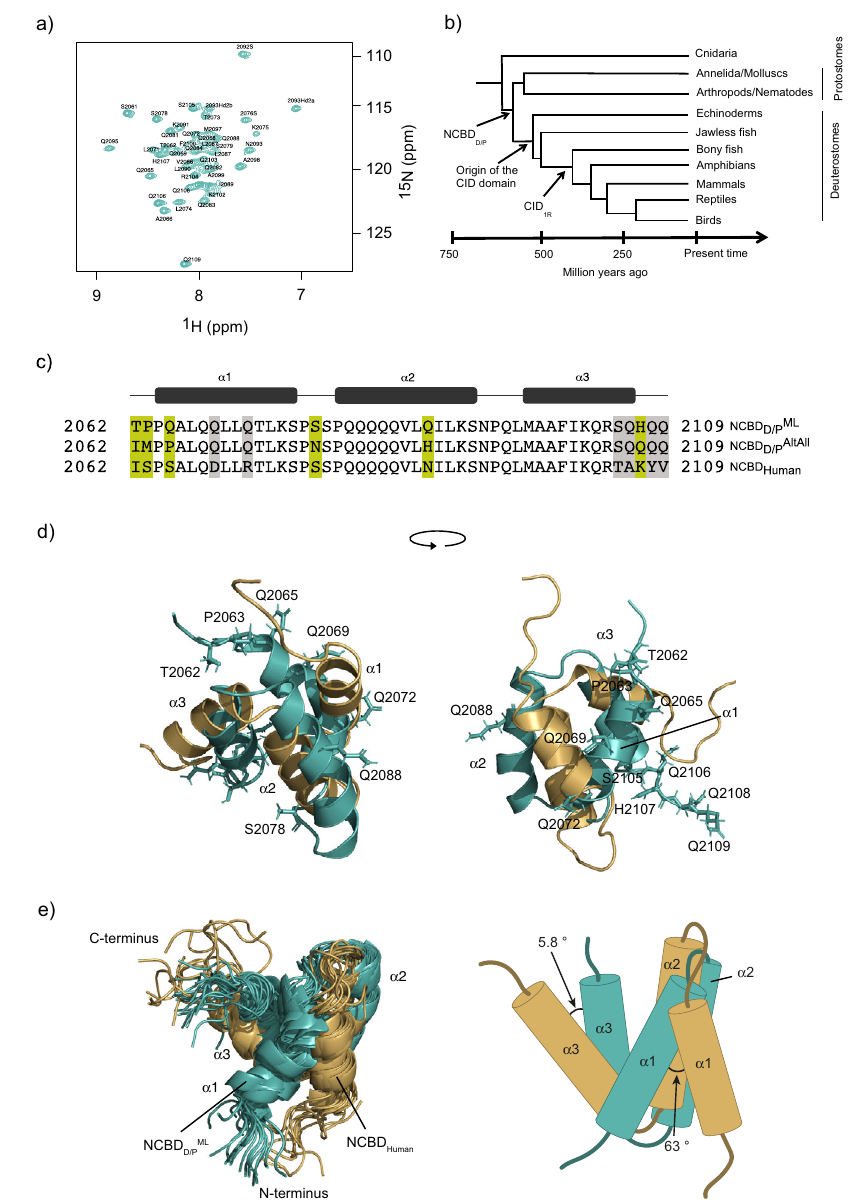
Fig. 1 Structures of ancestral and human NCBD domains. a 1 H- 15 N HSQC spectrum of NCBD D/P ML at pH 2.4 with assigned residues. All assignments and the structural coordinates have been deposited in the PDB data bank with accession number BMRB ID 34635 and PDB code: 7OSR. b A schematic tree depicting the relationship between the deuterostome/protostome (D/P) ancestor and modern species. The time points on the x-axis are approximate, in particular the divergence of protostomes and deuterostomes. c Sequence alignment for NCBD Human , NCBD D/P ML , and NCBD D/P AltAll . The residues differing between NCBD D/P ML and NCBD D/P AltAll are marked in celery green while additional differences to NCBD Human are marked in gray. d , e Comparison of the NMR structure of ancestral NCBD D/P ML solved at pH 2.4 (teal, PDB code: 7OSR), and the previously determined human NCBD (gold, 2KKJ) 8 . Note that the structure of human NCBD was solved using a slightly longer construct and at pH 6.5. d Structural alignment of NCBD D/P ML (teal) and NCBD Human (gold) with the residues that differ between the two variants represented as stick models. e Structural alignment of the 20 lowest energy structures of the NCBD D/P ML domain with those of NCBD Human . Tilt angles for α 1 and α 3 from the lowest energy structures. See Table S1 for the determination of the tilt